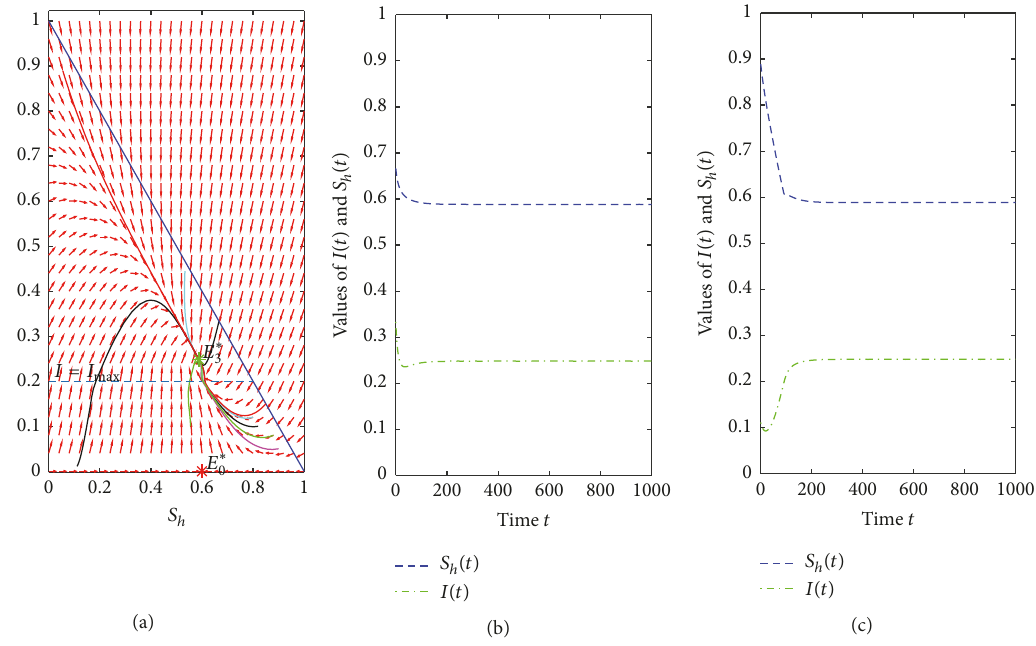
Figure 7: Trajectory figure and time plots of Example 5.